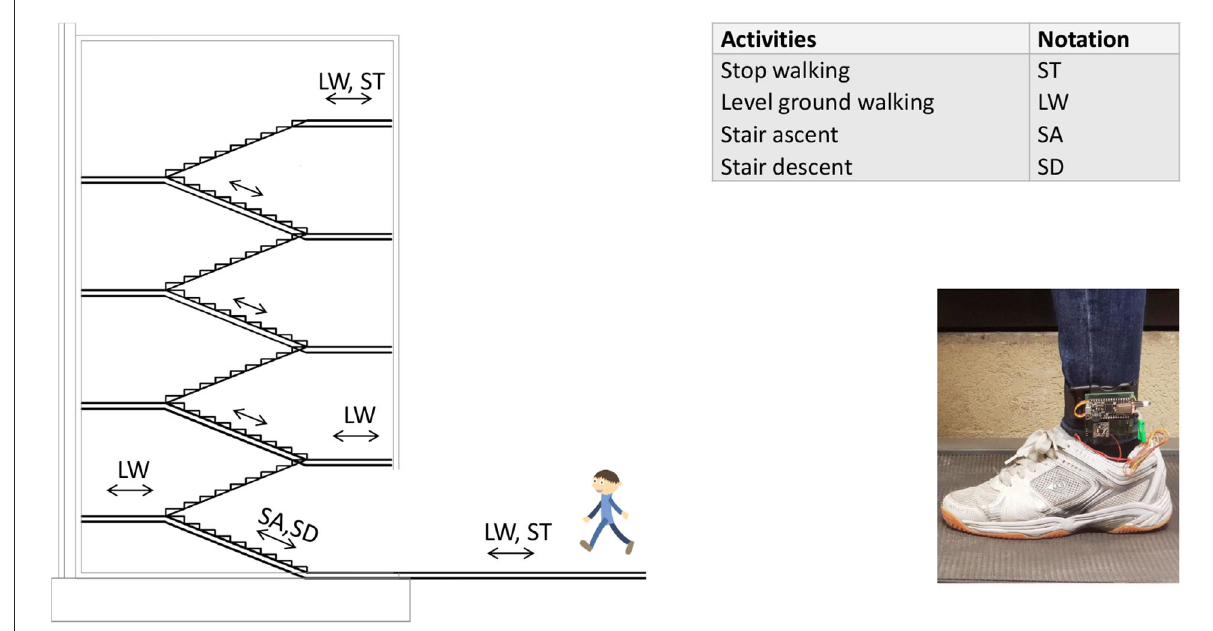
FIGURE7 The experimental platform is set up with four locomotion modes and six mode transitions. Subjects wore the shoes equipped FSRs under the toe and the heel and performed tasks: Standing and walking on the flat ground for 5 min before walking up the stairs; climbing the stairs to the fourth floor; and walking downstairs to the starting position.